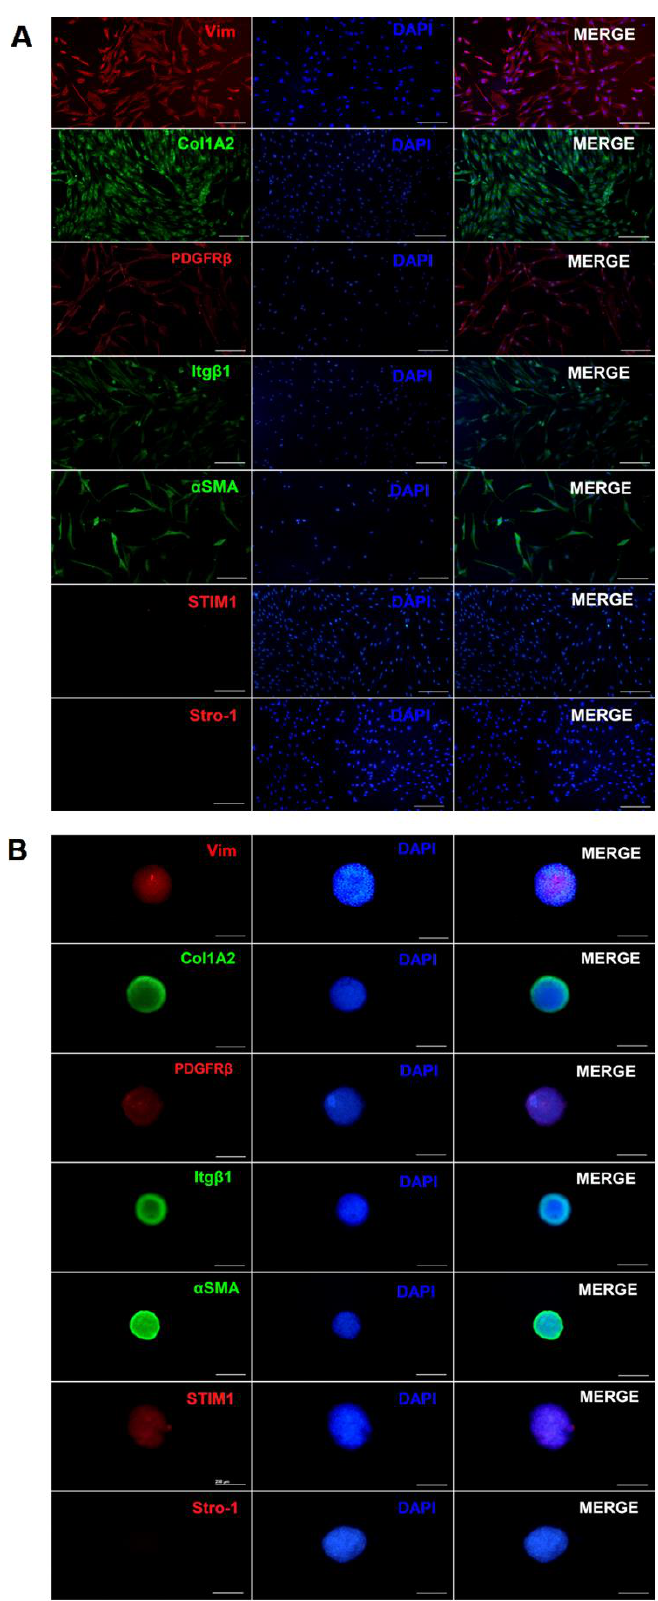
Figure 2. Immunofluorescence analysis. ( A ) Characterization by of a population of hGFs. Positive markers panel: Vim, Col1A2, PDGFR β , Itg β 1, and α SMA. Cells were negative for STIM1 and Stro-1. ( B ) hGF spheroids express STIM1. Scale bar, 200 µm; 10× magnification. The data are from three representative experiments.